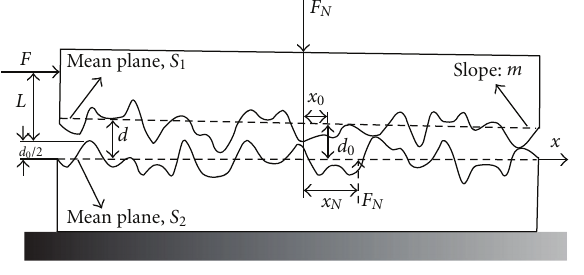
Figure 1: Contacting two rough surfaces with a slight rotation of the mean plane.